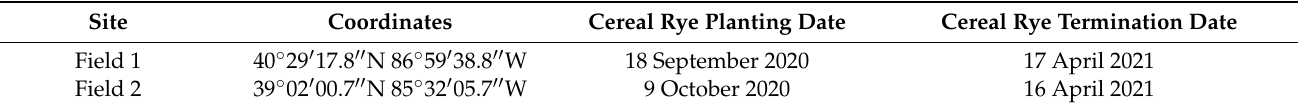
Table 1. Location and cereal rye management for the two field sites where UAV flights